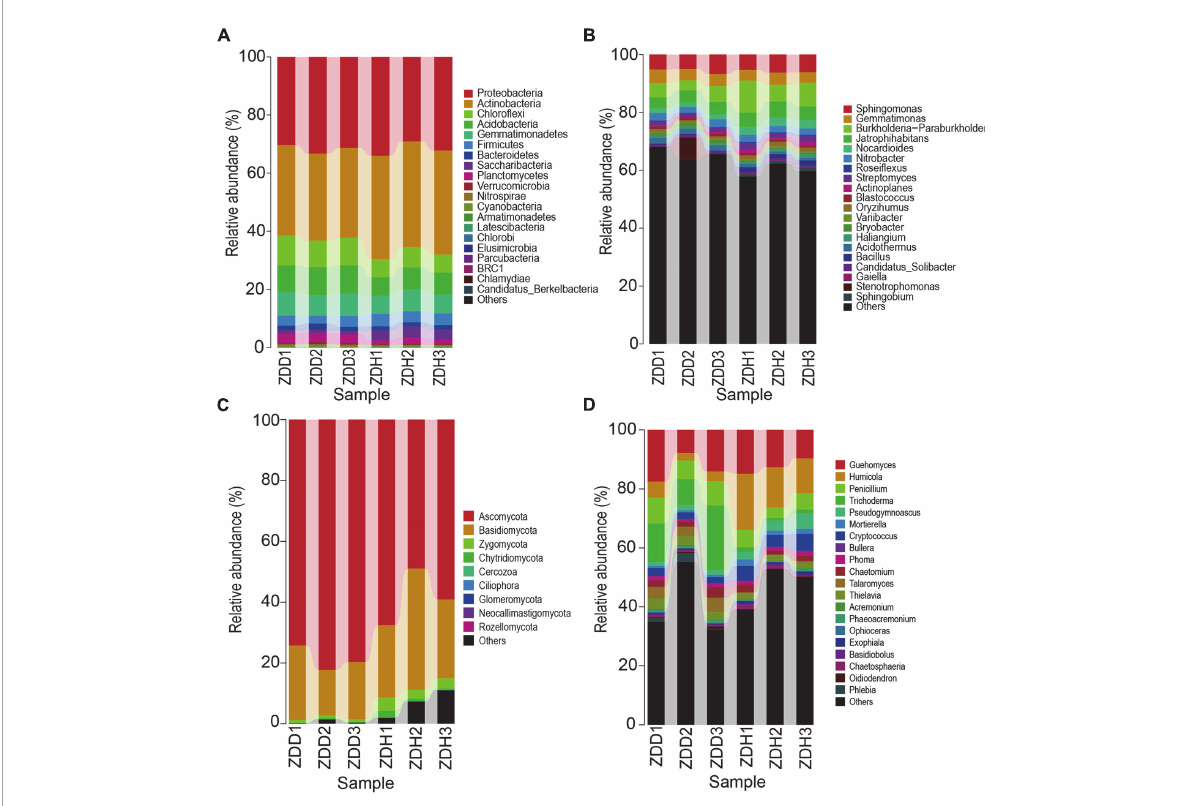
FIGURE2 Relative abundances of dominant microbial taxonomic groups in maize rhizosphere soil. (A) Dominant bacterial phyla. (B) Dominant bacterial genus. (C) Dominant fungal phyla. (D) Dominant fungal genus. Others represent taxonomic groups with low content or those that are unclassified. ZDD refers to rhizosphere soil with severe stalk rot disease, and ZDH refers to the rhizosphere soil with disease-free near by the